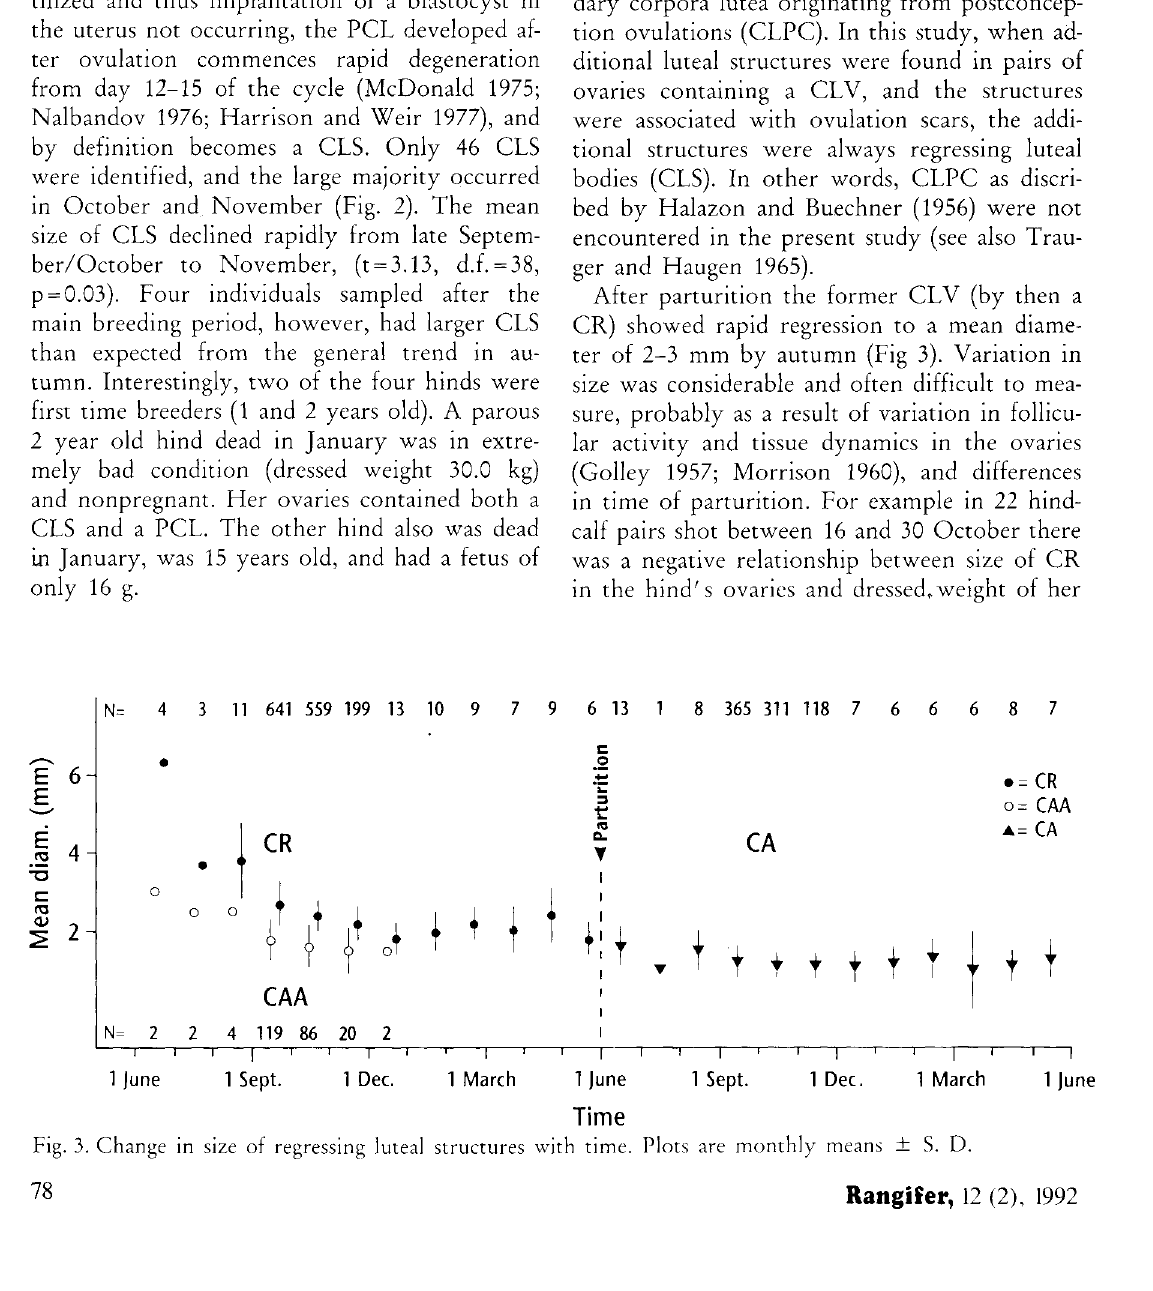
Fig. 3. Change in size of regressing luteal structures with time. Plots are monthly means ± S. D